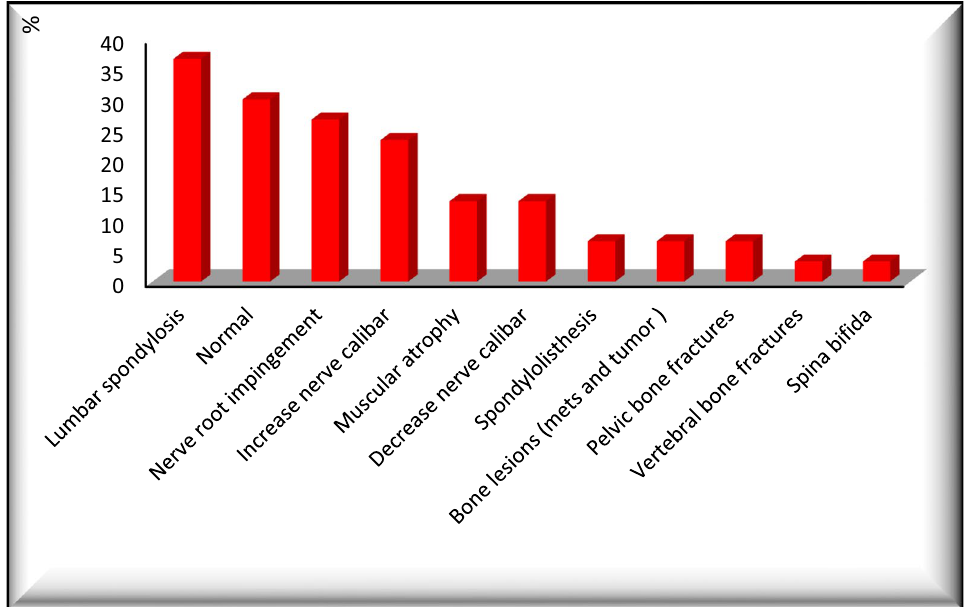
Fig. 1 Distribution of studied cases according to MRI findings. N.B: One patient may have more than one MRI finding